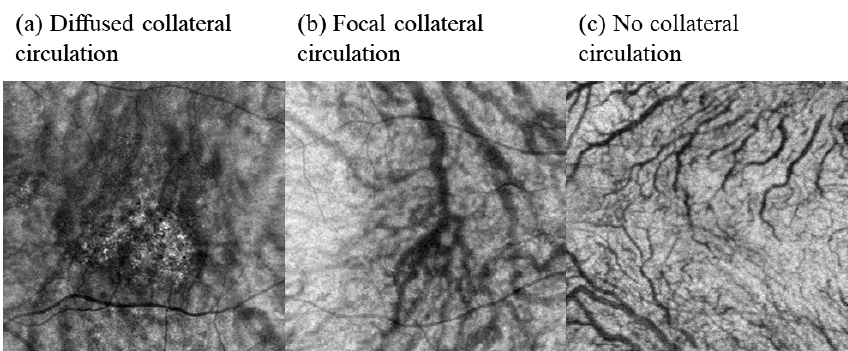
Figure 2. Representative 6 × 6 mm En face images showing the diffused collateral circulation ( a ), focal collateral circulation ( b ) and no collateral circulation vessels ( c ).